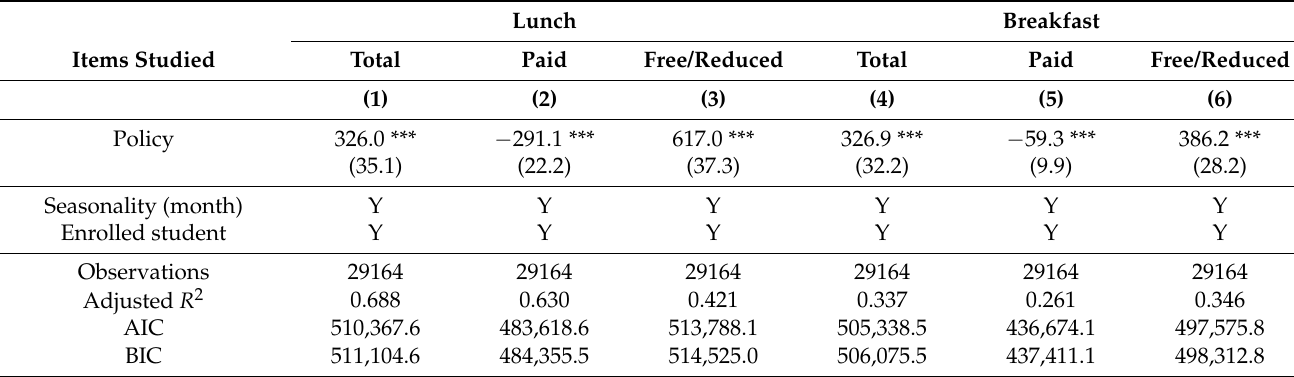
Table 3. Policy impacts on served